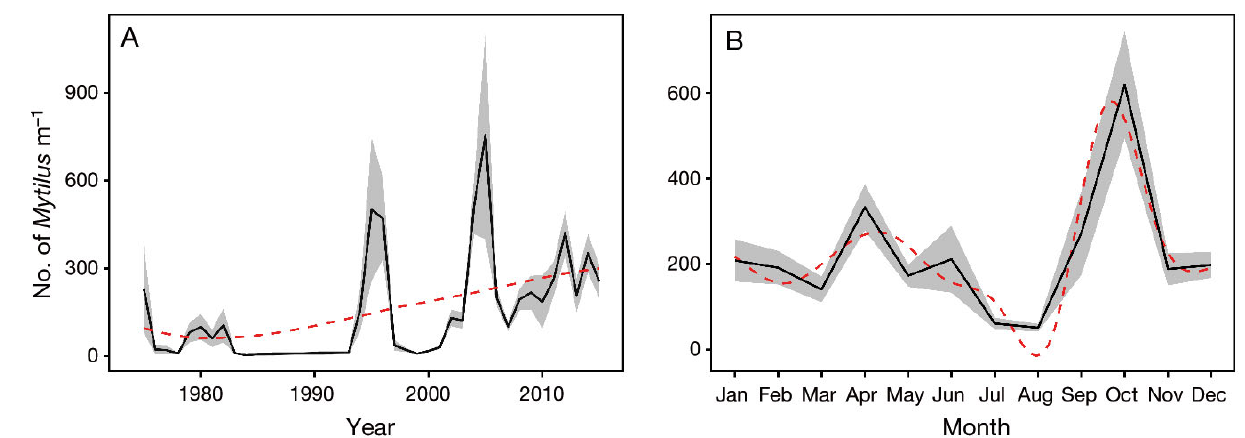
Fig. 2. (A) Long-term and (B) seasonal trend in mean Mytilus spat abundance m –1 rope. The red dashed line is the smoothed time series using a cubic spline and 95% confidence intervals (grey